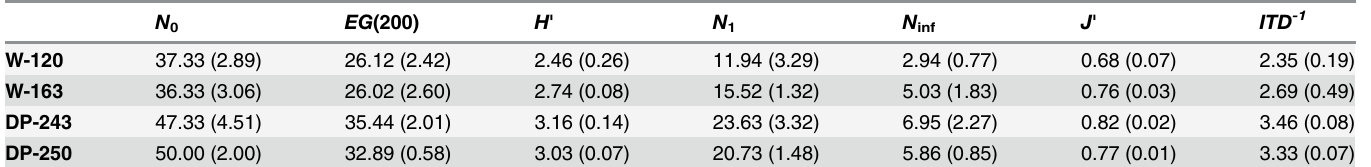
Table 6. Overview of structural diversity ( N 0 , EG(200) , H ’ and N 1 ) and evenness ( N inf and J ’ ), as well as a functional diversity measure ( ITD -1 ) with their respective standard deviation for the nematode assemblages of the different stations calculated in PRIMER and averaged over three replicates.